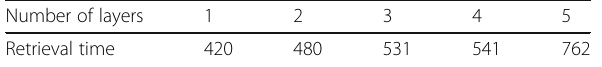
Table 1 Image retrieval time Number of layers